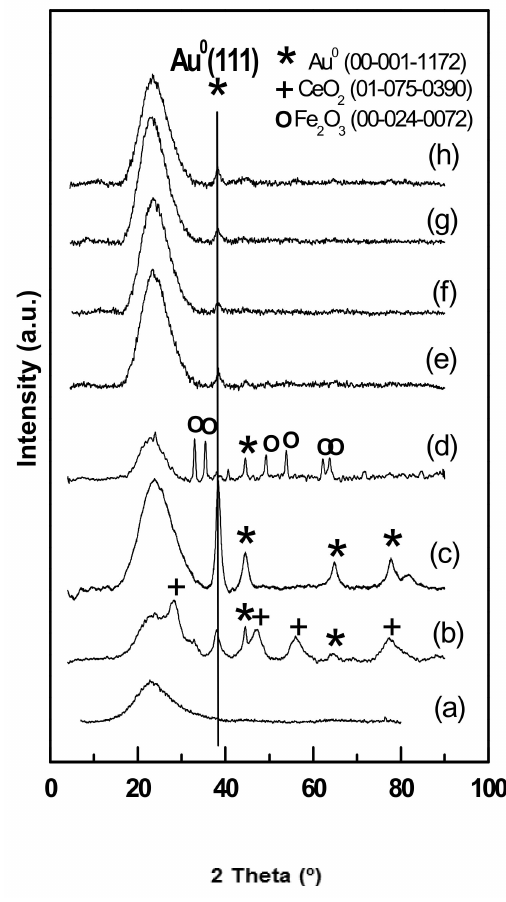
Figure 5. Wide-angle XRD patterns of the as-prepared Au samples supported on different mesoporous silica substrates: ( a ) Au/SBA-15; ( b ) Au/CeO 2 /SBA-15; ( c ) Au/TiO 2 /SBA-15; ( d ) AuFe 2 O 3 /SBA-15; ( e ) Au/MgO/SBA-16; ( f ) Au/MgO/SBA-15; ( g ) Au/MgO/HMS; ( h )